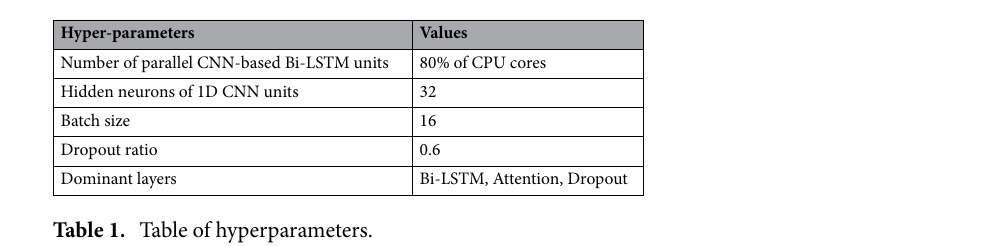
Table 1. Table of hyperparameters.